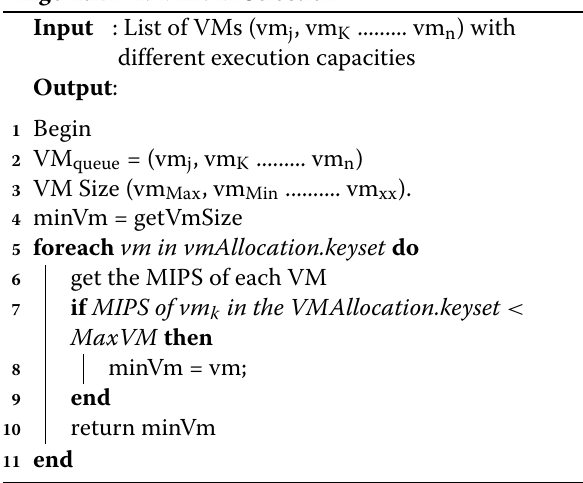
Algorithm 4: MinVM